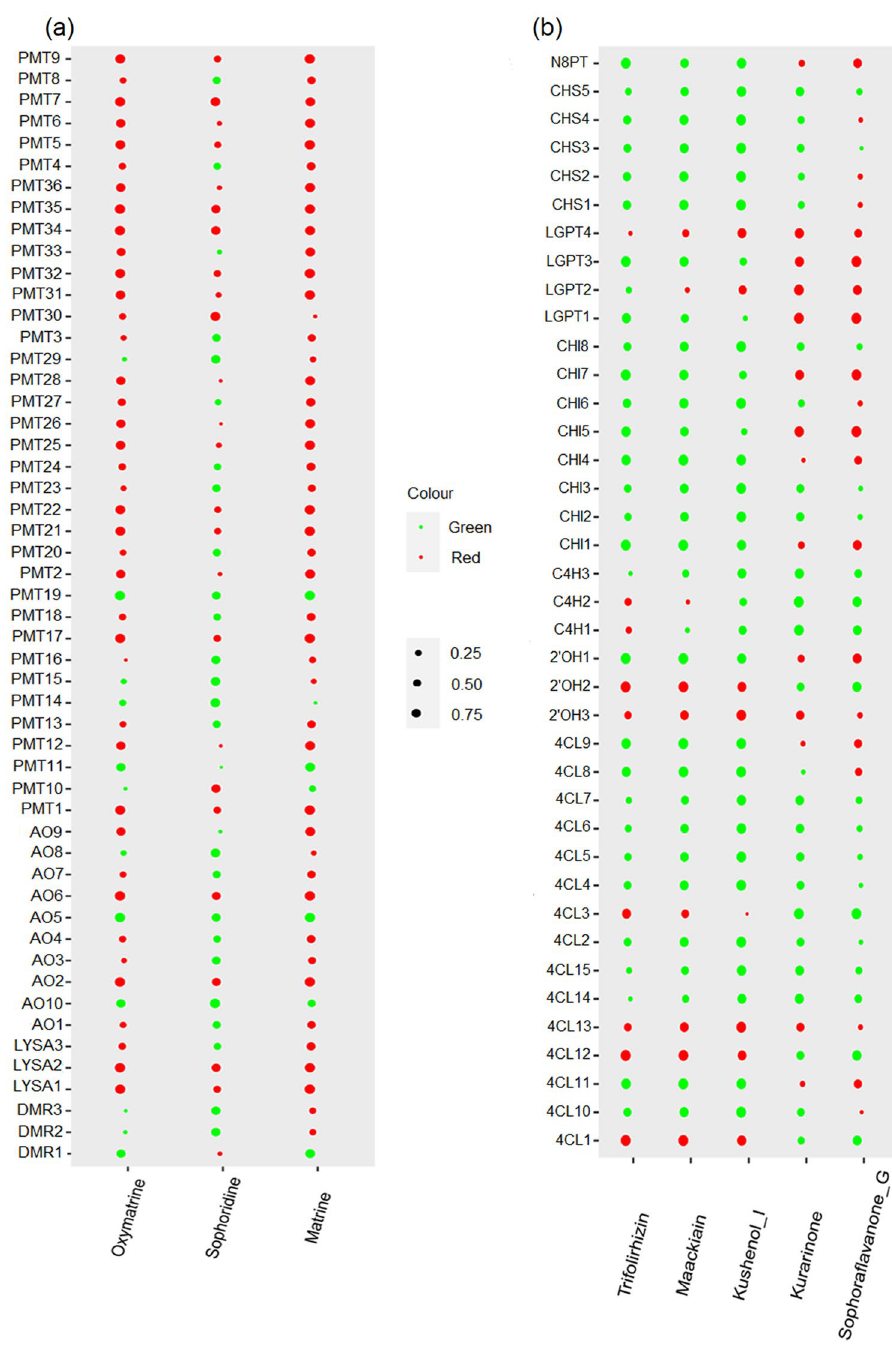
Figure 6. Pearson correlation bubble chart of the transcript expression and chemical component contents in S. flavescens : ( a ) alkaloids and ( b ) flavonoids. The size of the circle represents the correlation coefficient. The color red represents a positive correlation, whereas the color green represents a negative